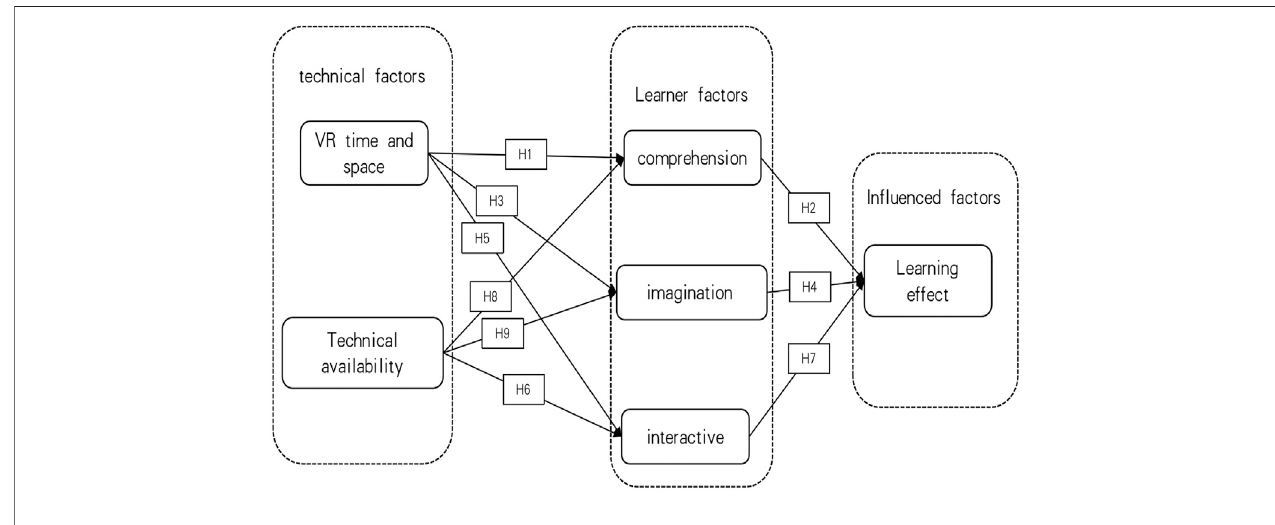
FIGURE 2 | Diagram of hypothetical model used in the study.